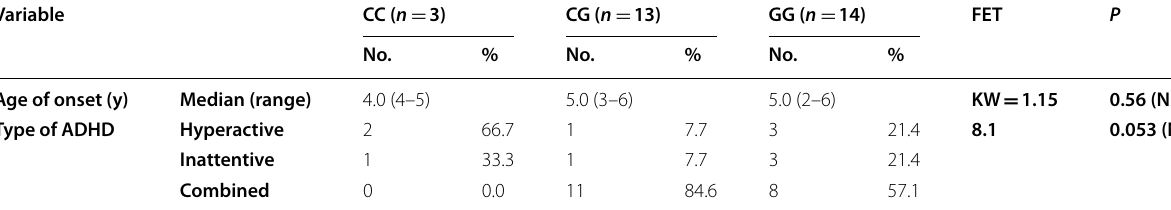
Table 3 Disease characters according to gene polymorphism